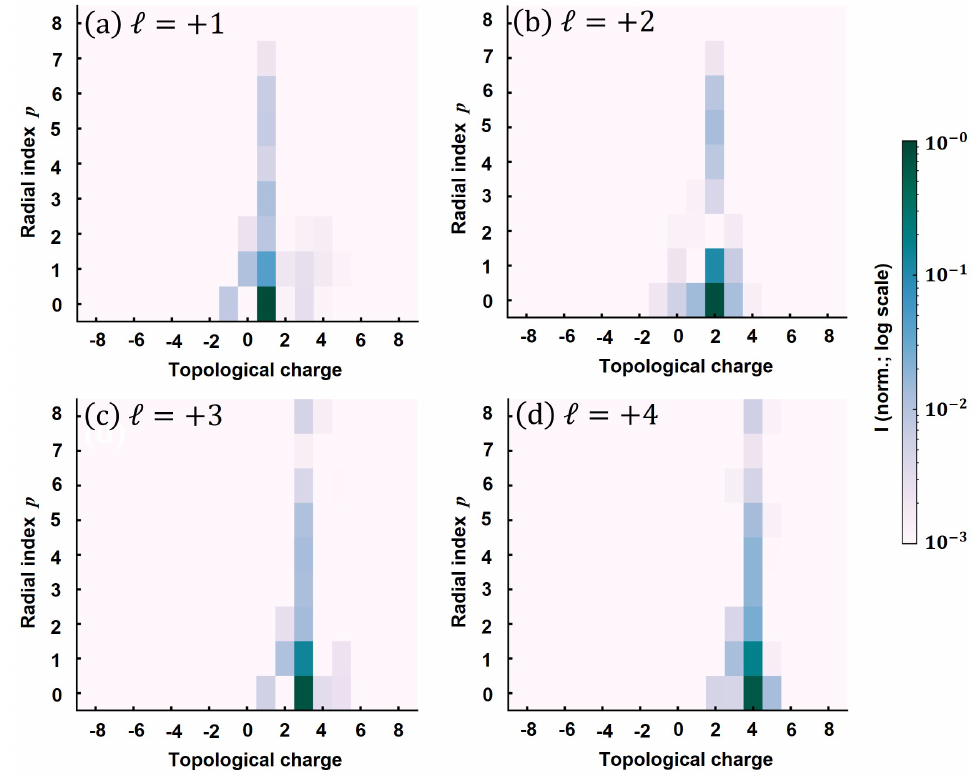
Figure 5. Modal analysis of the vortex beams. The (cid:96) , p modal content for ( a – d ). The global LG spectrum is normalized to unity. The contribution to the desired OAM mode is ( a ) ∼ 94%, ( b , c ) ∼ 93%, and ( d ) ∼ 92%, indicating high OAM purity in all the cases. The energy fraction contained in the dominant azimuthal and principal ( p = 0) radial mode is: ( a ) ∼ 86%, ( b ) ∼ 79%, ( c ) ∼ 73%, and ( d ) ∼